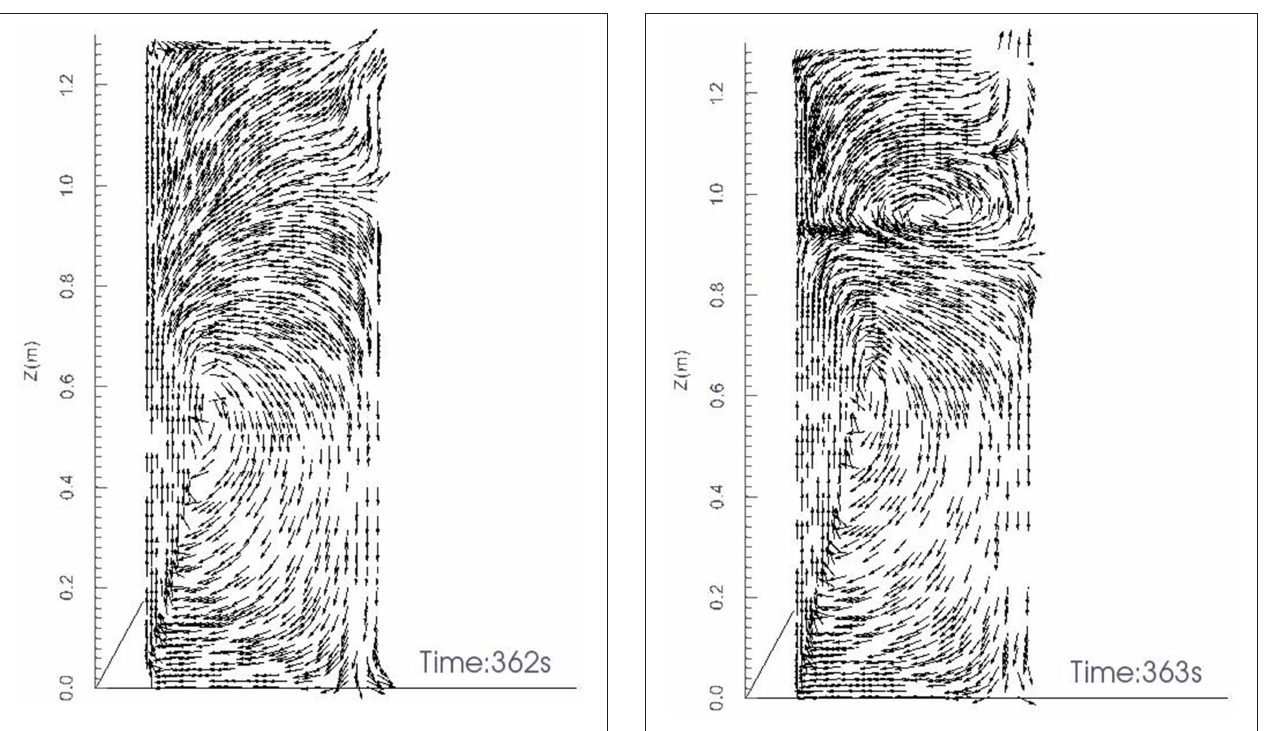
FIGURE 7 | Flow field at